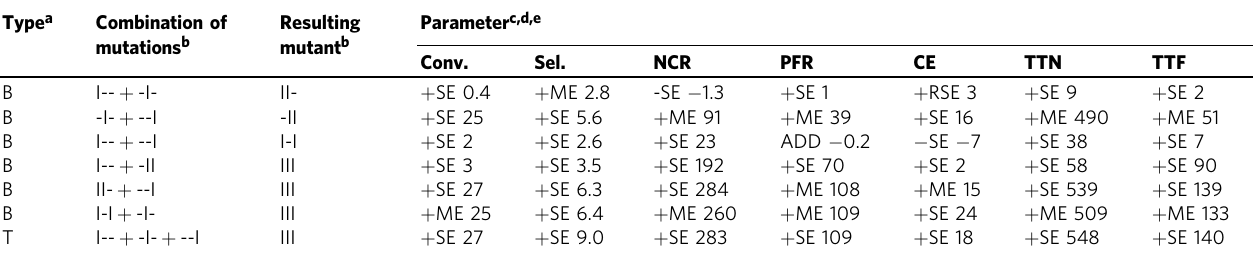
Table 1 Epistatic analysis of all possible mutational combinations on multiple parameters towards formation of product 2 β -